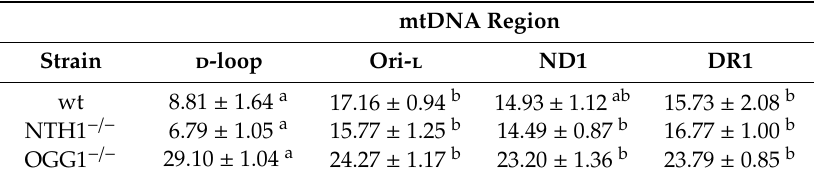
Table 1. Formamidopyrimidine DNA glycosylase (Fpg)-sensitive damage (%) at specific mitochondrial DNA (mtDNA) regions in the three mouse